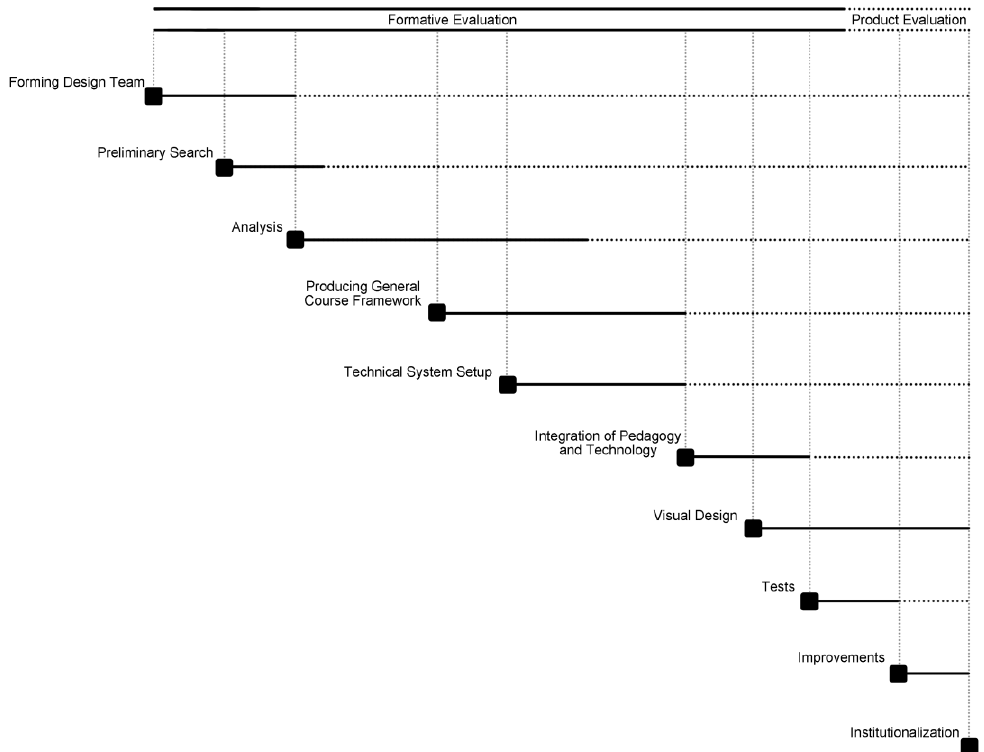
Figure 3. Process flow of experience-based e-course design